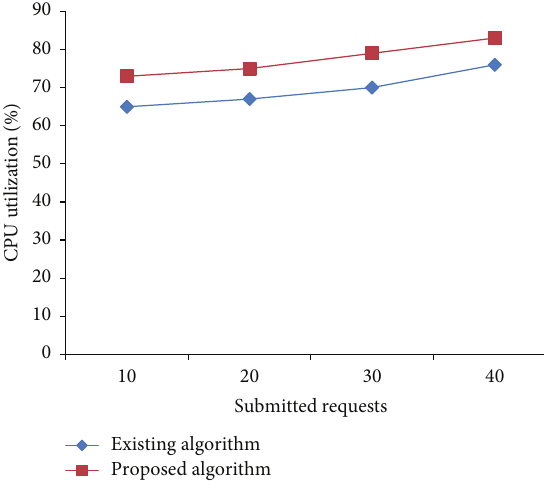
Figure 5: Utilization comparison of Haizea.